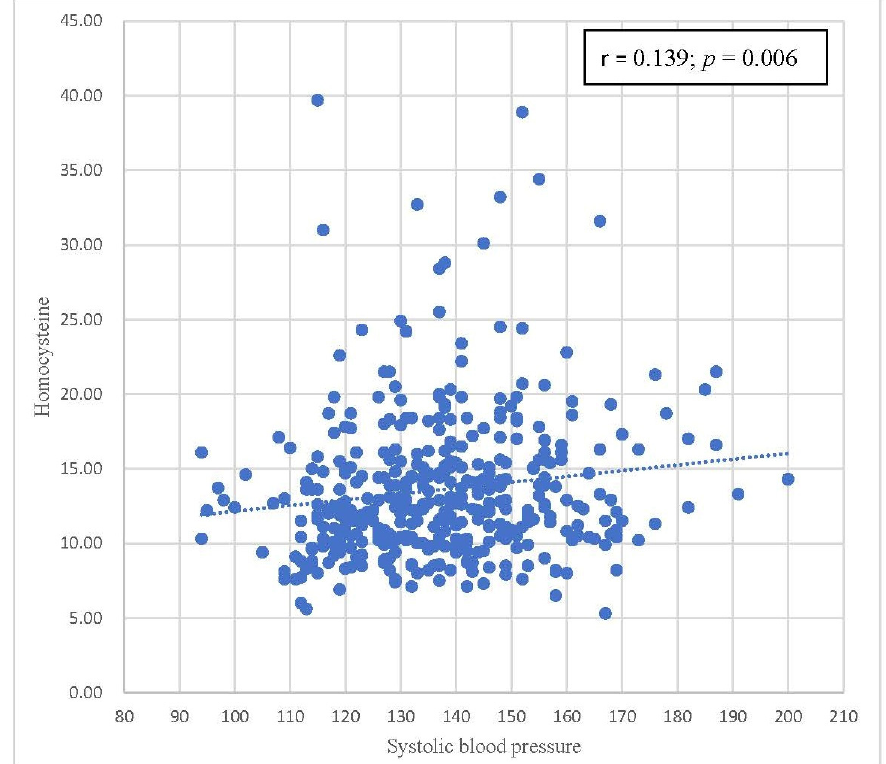
Figure 2. Scatterplot with the fit line of homocysteine levels by waist circumference.